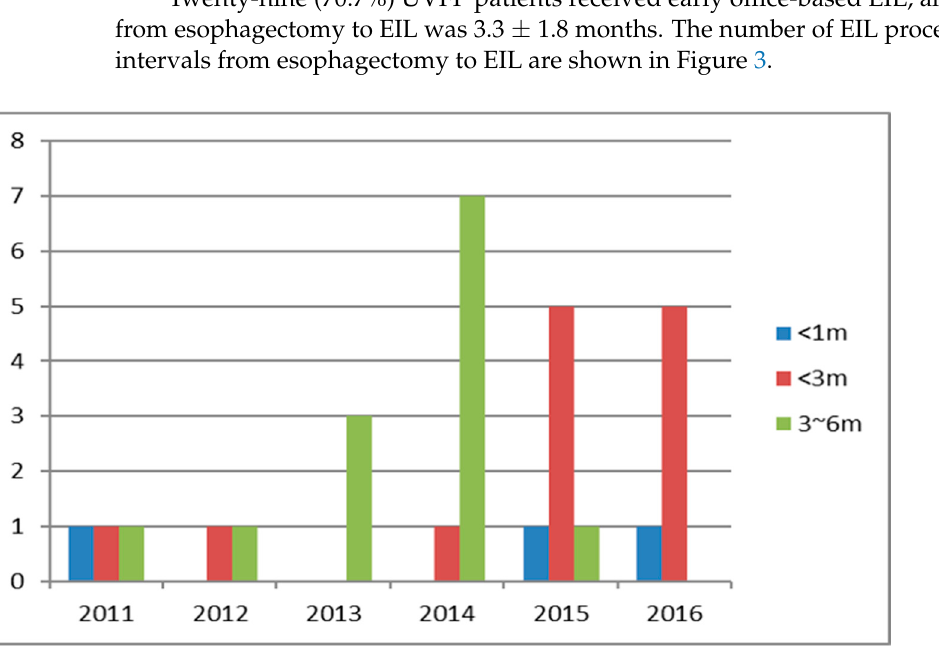
Figure 3. From 2011 to 2016, the number of injection laryngoplasty procedures for unilateral vocal fold paralysis has increased, and this procedure is now performed earlier.